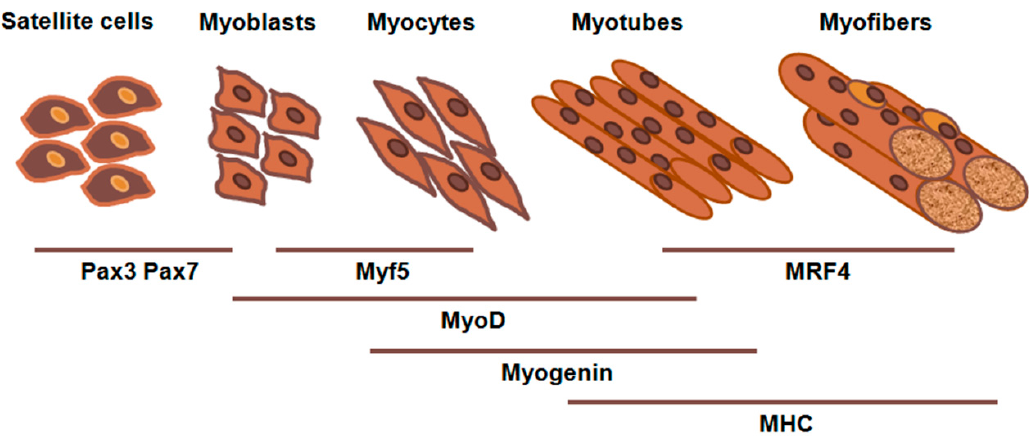
Figure 2. Schematic illustration of the skeletal muscle differentiation process. During myogenesis, Pax3 and Pax7 are activated in quiescent progenitors. Then, progenitor cells differentiate into proliferating muscle precursor cells (myoblasts) and Myf5, MyoD, and myogenin expression stimulates myoblasts to differentiate into myotubes. The terminal stage of differentiation is mediated by the activation of genes responsible for muscle fiber (myofiber) architecture and functionality such as MHCs. Pax: paired box; Myf5: myogenic factor 5; MyoD: myogenic factor 3; MRF4: myogenic regulatory factor 4; MHC: myosin heavy chain.